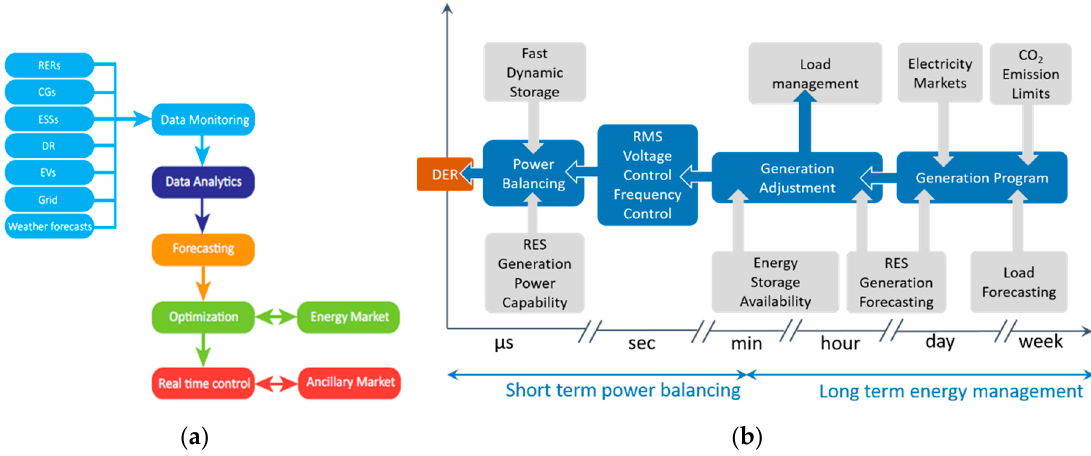
Figure 2. Microgrid energy management system: ( a ) microgrid EMS functions [34]; ( b ) timing classification of the EMS control functions. Adapted from [35].